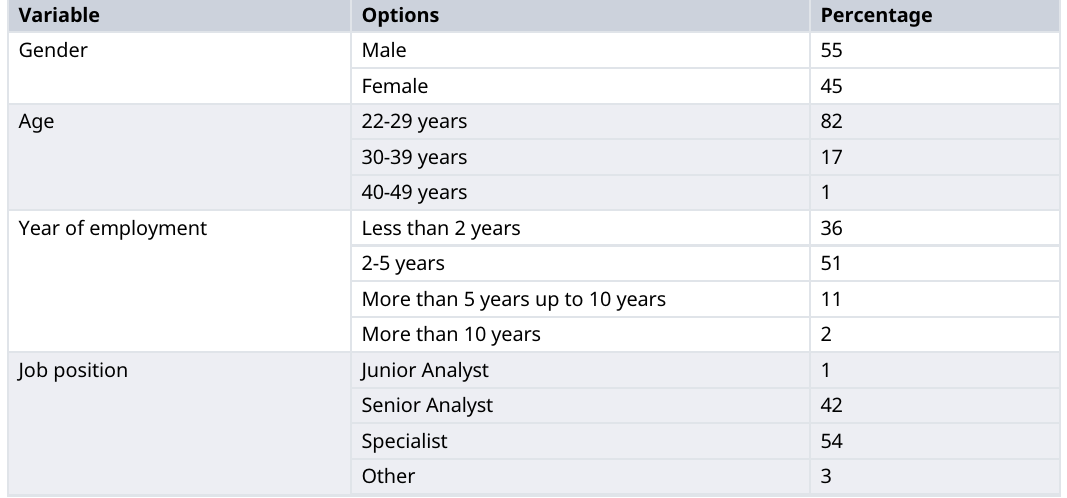
Table 2. Descriptive statistics of the AML department employees ’ demography.